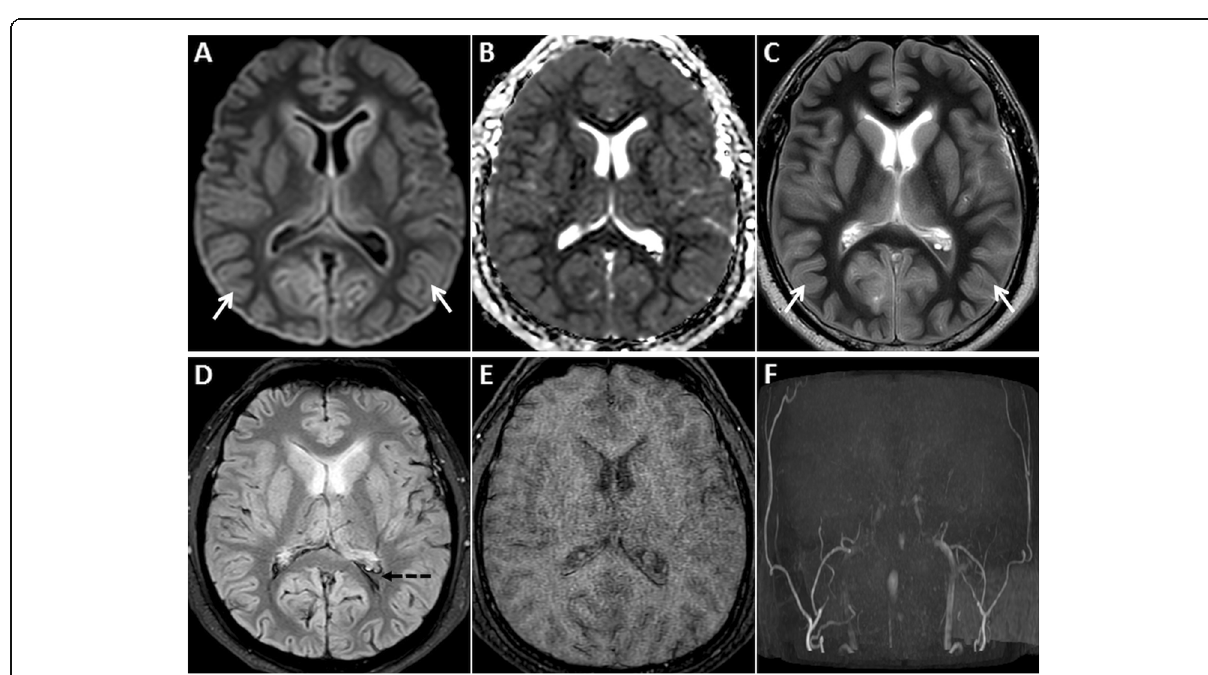
Fig. 2 MRI of the brain performed in the subacute phase of HIE. DWI hyperintensity is noted in the deep grey nuclei and extensively in the cerebral cortices (arrows) on axial DWI image ( a ). There is no signal drop on axial ADC image ( b ). Diffuse cortical swelling and signal changes (arrows) are appreciated better on the axial T2W image ( c ). Minimal intraventricular blood (dashed arrow) is seen on axial GRE image ( d ). Axial source 3D-TOF MRA image ( e ) and reconstructed maximum intensity projection MRA image of Circle of Willis ( f ) show no flow signal in the intracranial